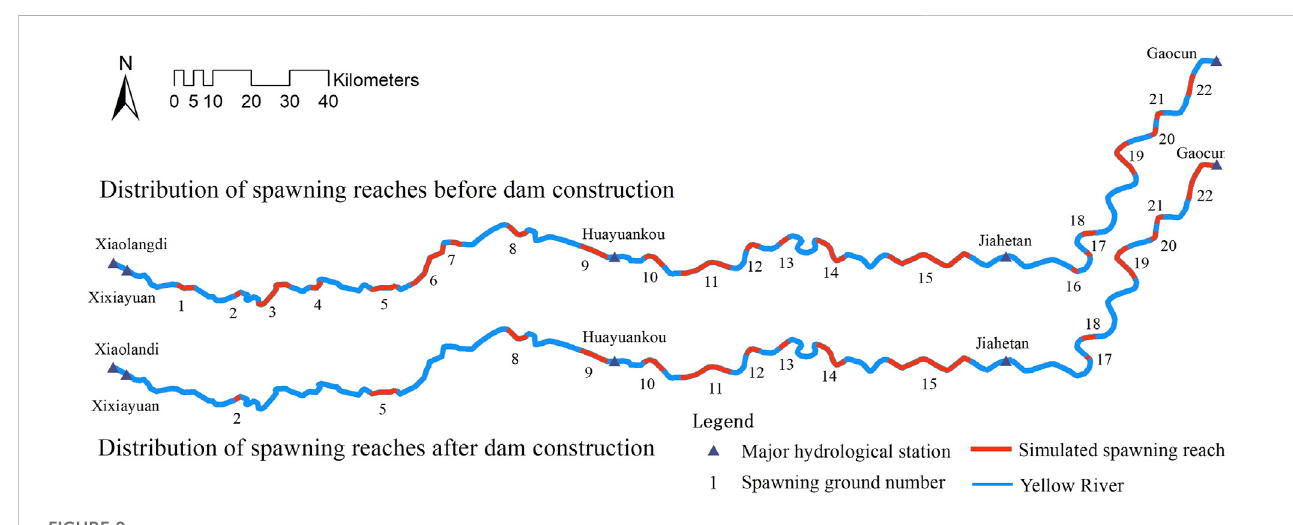
FIGURE 9 SimulateddistributionoftheYellow Rivercarpspawningreaches fromApril1 toJune 30in1980 – 1990 (beforedamconstruction)and2006 – 2018(after dam